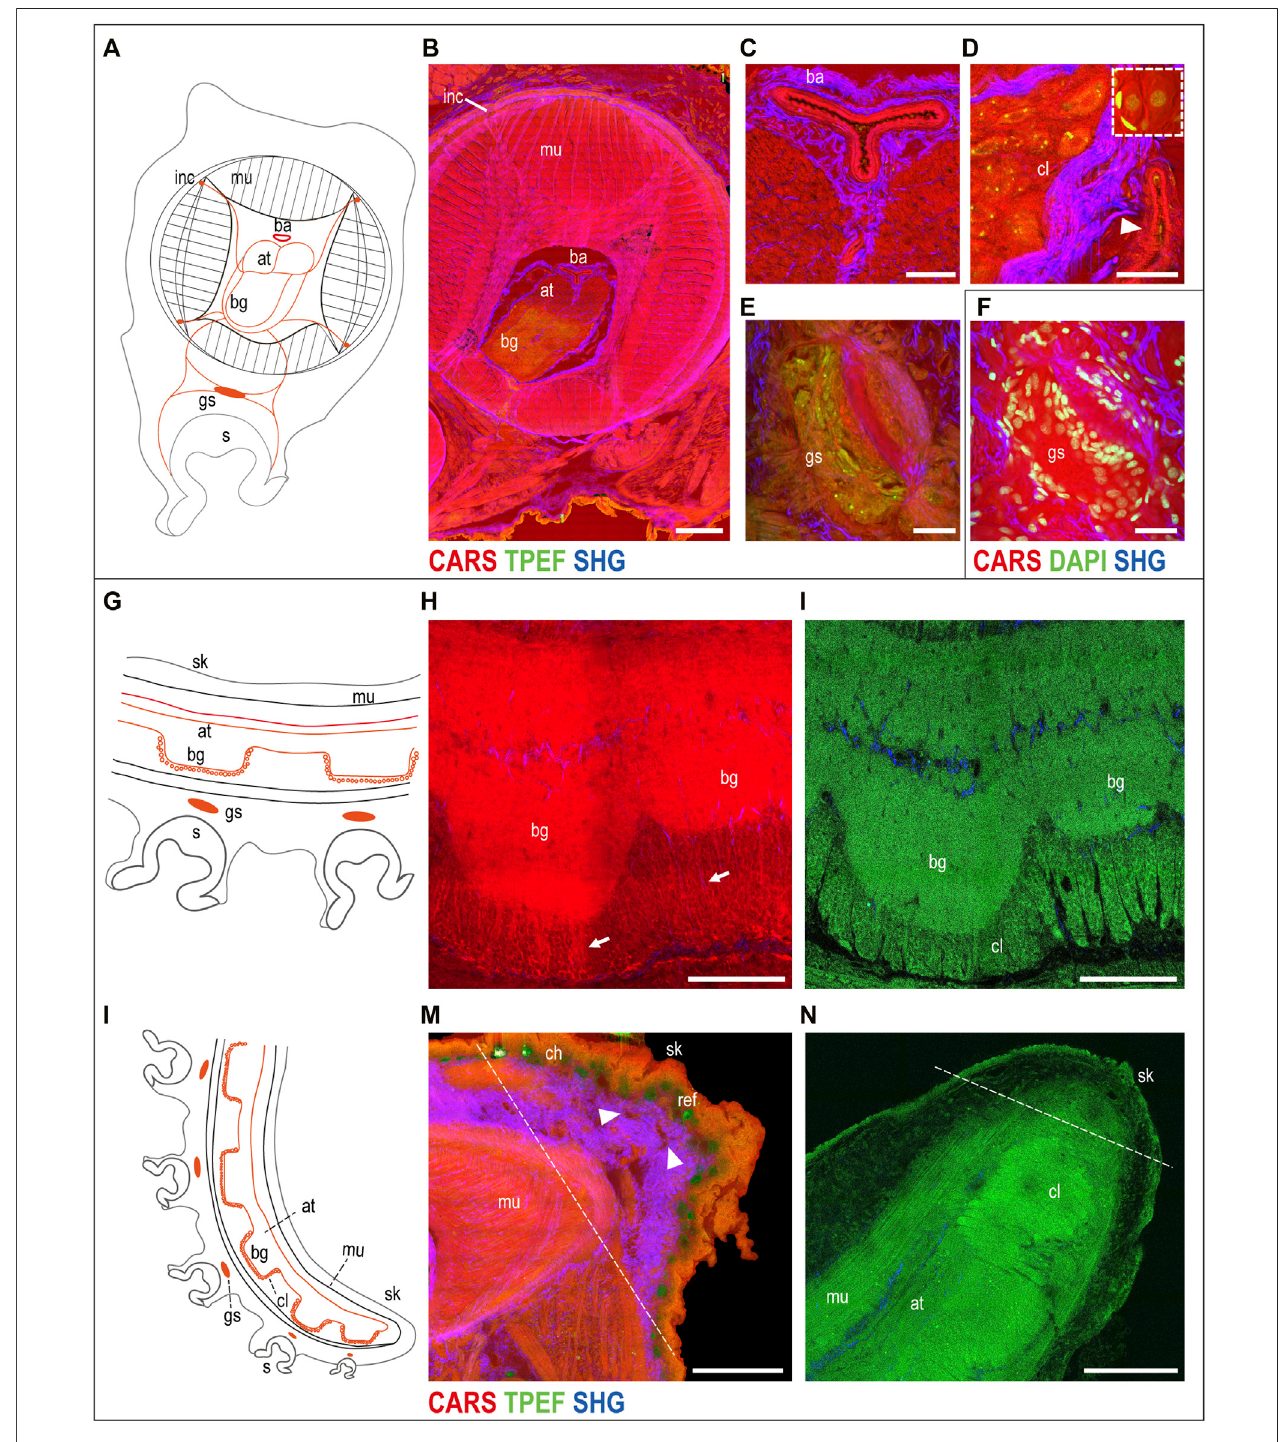
FIGURE 2 | Uninjured arm. Schematic drawings of octopus arm morphology in transverse (A) and sagittal (G,L) planes. (B) Multiphoton microscopy image of an arm transverse section showing the three muscle bundles belonging to the intrinsic musculature of the arm (CARS) and the connective tissue sheaths enveloping them (SHG). The axial nerve cord (comprising two axonal tracts on the dorsal side and brachial ganglia on the ventral side) and the four intramuscular nerve cords are clearly identi fi ed (CARS and TPEF). (C) Above the axonal tracts, the brachial artery is visible (CARS) surrounded by connective tissue (SHG). (D) Outer cellular layer of a brachial ganglion appears comprising small and big neurons emitted in CARS and TPEF. DAPI counterstaining (white dotted rectangle) highlights neuron nuclei and supporting cells surrounding them. The arrowhead points a blood vessel around the nerve cord. (E) Ganglion of the suckers comprising a central neuropil and